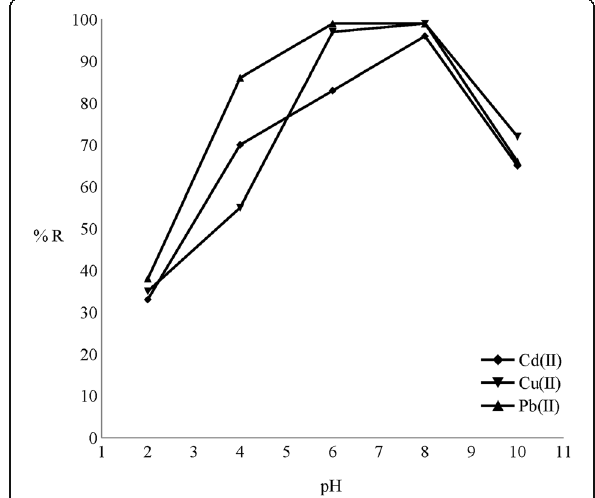
Fig. 1 Effects of pH on the recovery of Cd, Cu, and Pb, 0.2 μ